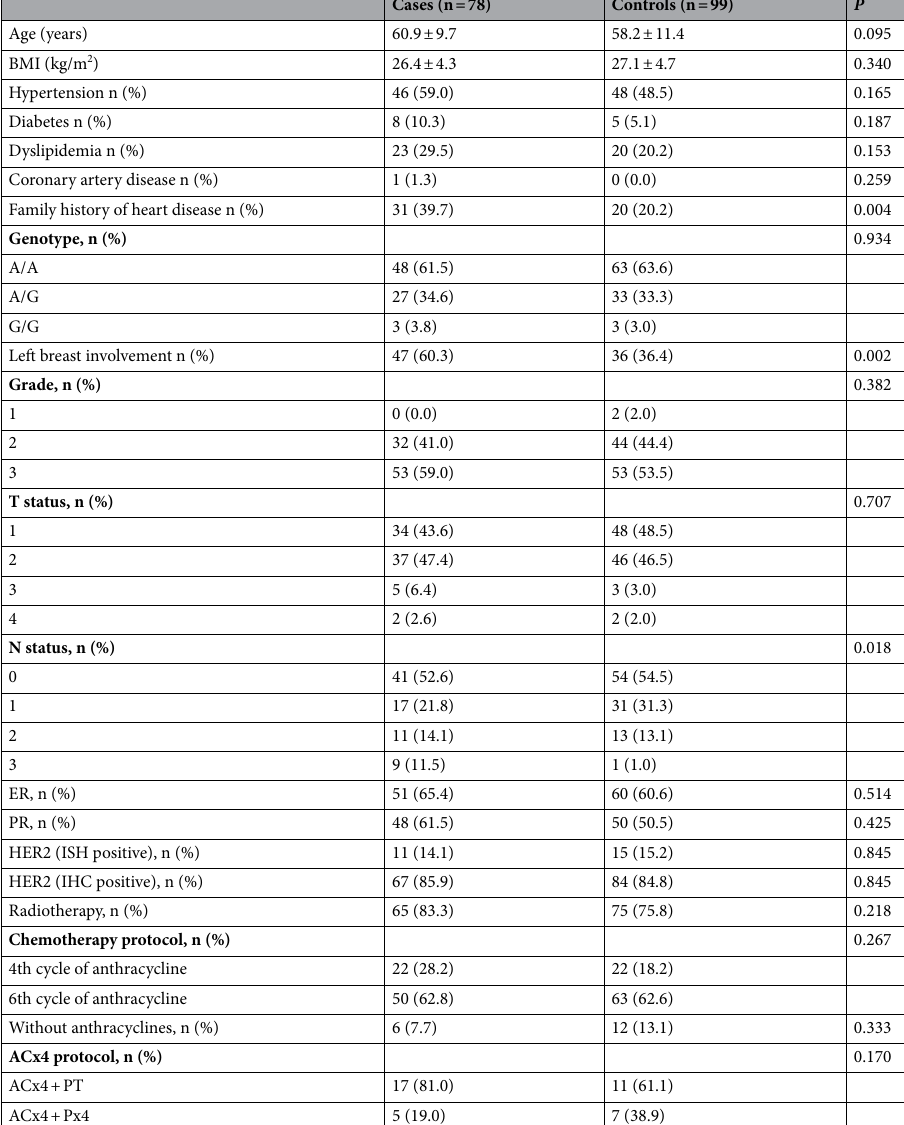
Table 1. Characteristics of patients with and without cardiotoxicity. BMI, Body Mass Index; HER2, Human epidermal growth factor receptor 2; A, Adenin; G, guanine; T, Tumor; N, Node; ER, Estrogen Receptors; PR, Progesterone Receptors; ISH, In situ Hybridization; IHC, Immunohistochemistry; AC, Doxorubicin + Cyclophosphamide; PT, Paclitaxel + Trastuzumab; P, Paclitaxel, P value was calculated with one- way analysis of variance